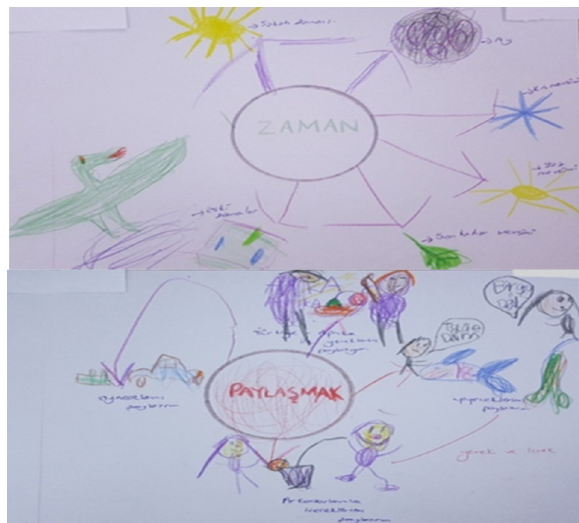
Figure 2. Several examples for the individual mind mapping